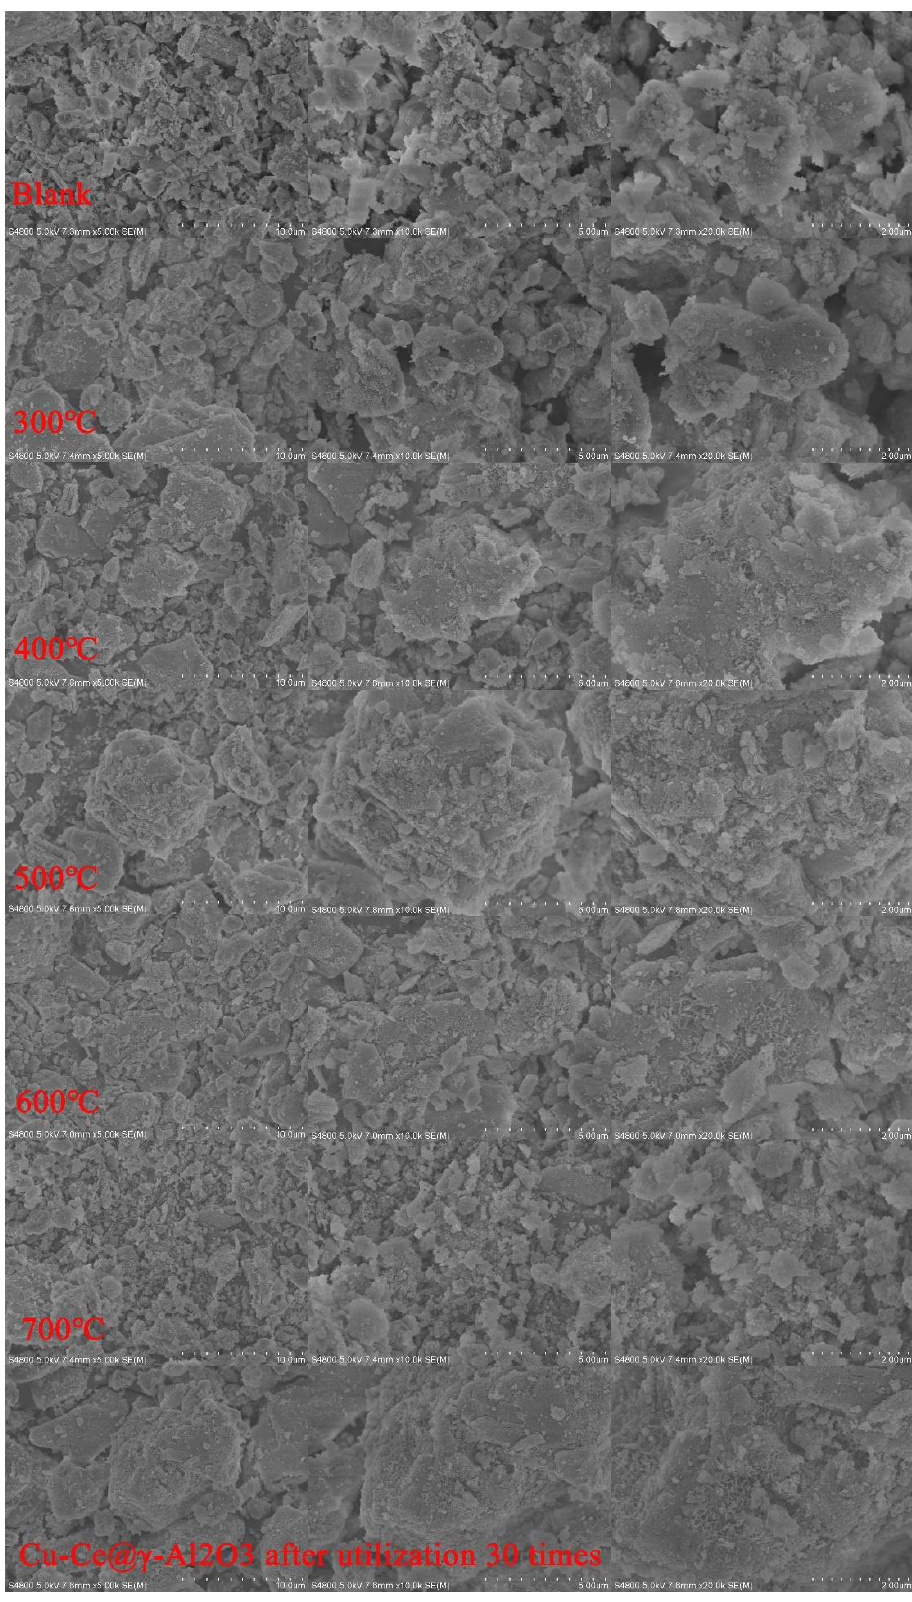
Figure 2. SEM characterization of catalysts (×5000, ×10,000, ×20,000 from left to right). Figure 3a suggests that the catalyst has the typical diffraction peaks of Al 2 O 3 at 2 θ = 33.16°, 37.68°, 47.06°, 56.19°, and 66.52°and show the same strength. At 2 θ = 2 9.15°,